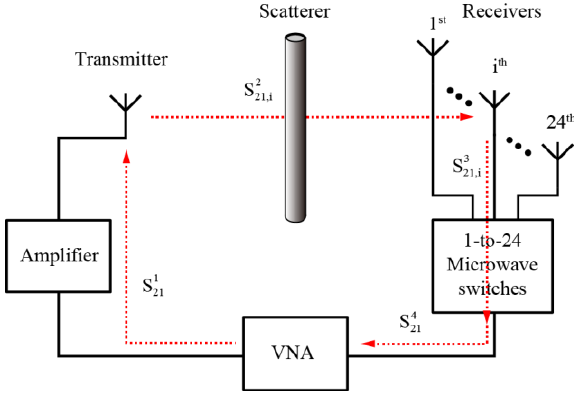
Figure 10. Calibration of the experimental setup.